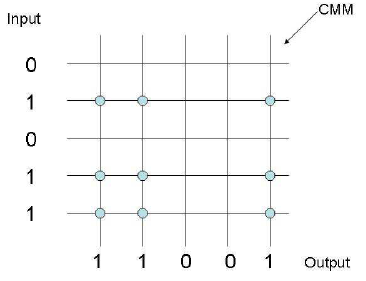
Fig. 3. Example of training a CMM. When both of the bit of the input and output vectors are ‘1’, a connection of corre- sponding position in matrix will be set.